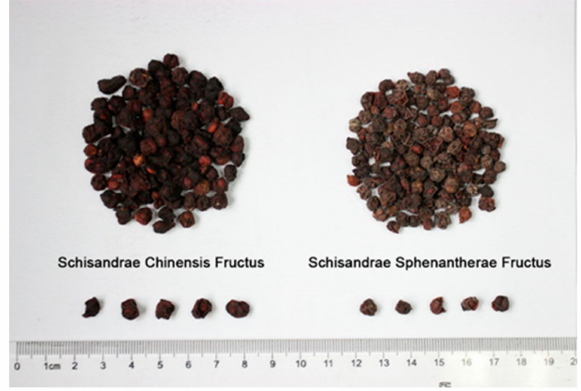
Figure 1. Samples of Schisandrae Chinensis Fructus and Schisandrae Sphenantherae Fructus collected from herbal